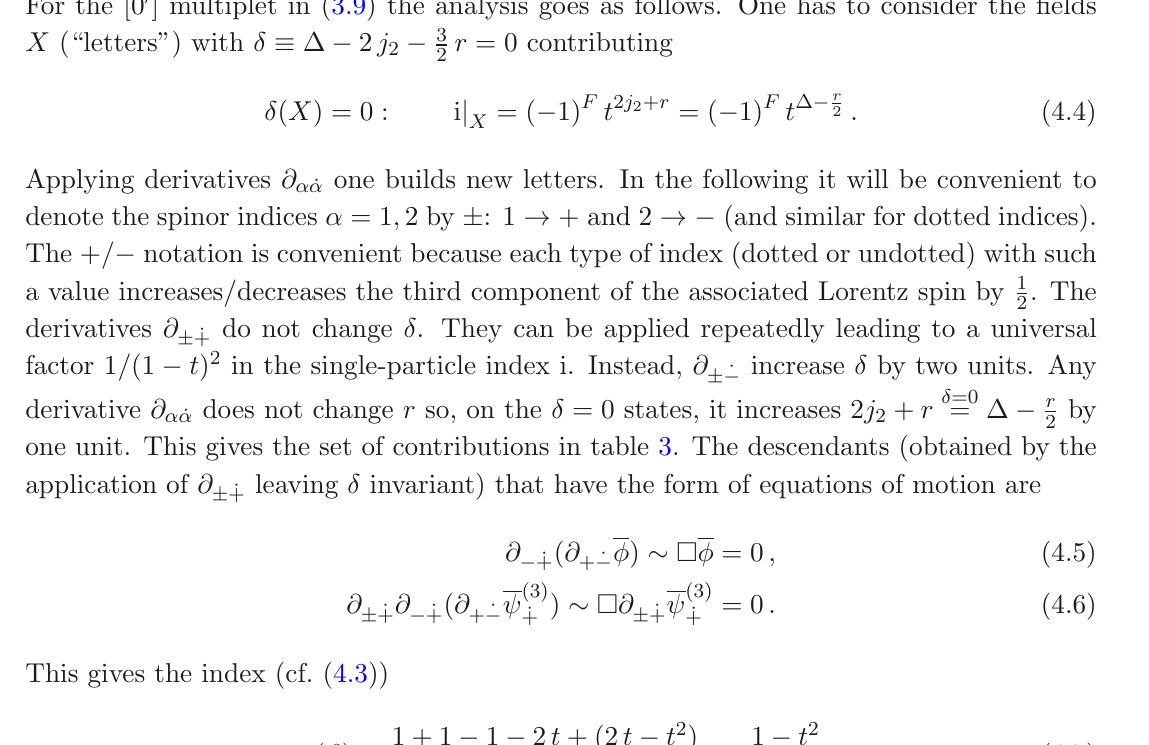
1 index contributes to j 1 ( j 2 ). 2 ± ± 3 ∆ 2 j 2 r = 0 2 ≡ − −